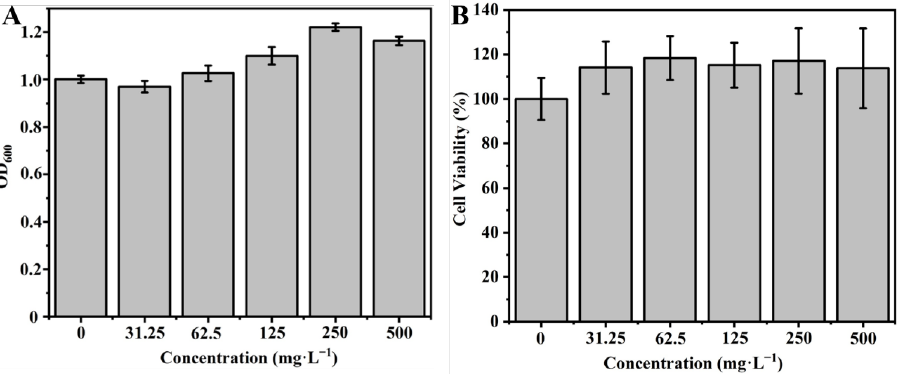
Figure 10. Biosafety evaluations of different concentrations of BMMs − PMAA/Fe 3+ . The OD 600 values of E. coli suspension ( A ), and biological activities of 16HBE cells ( B